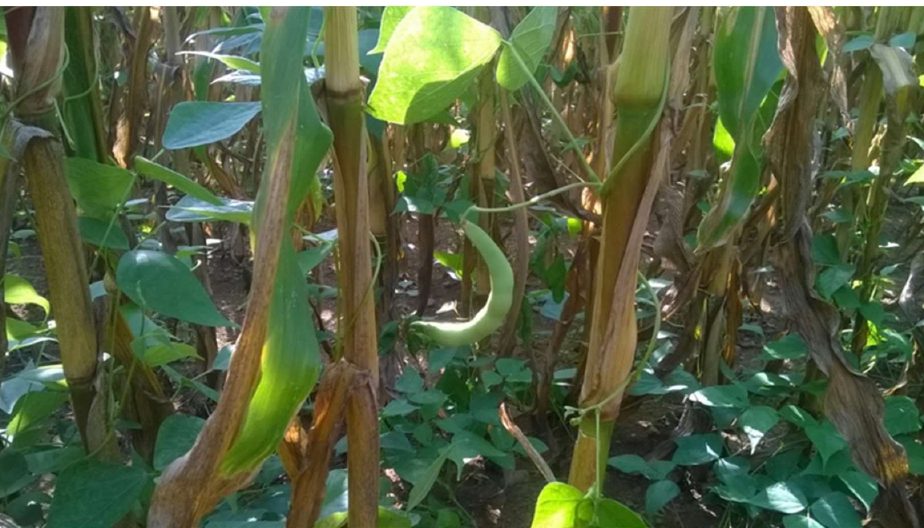
Figure 13. Impression of an intercropping system where maize ( Zea mays L.) is cultivated for bioenergy production and runner bean ( Phaseolus vulgaris var. vulgaris L.) for human nutrition. The runner bean uses maize as a climbing aid and has little or no negative impact on the yield level of maize. Such practices can increase the land equivalent ratio compared to monoculture farming practices.